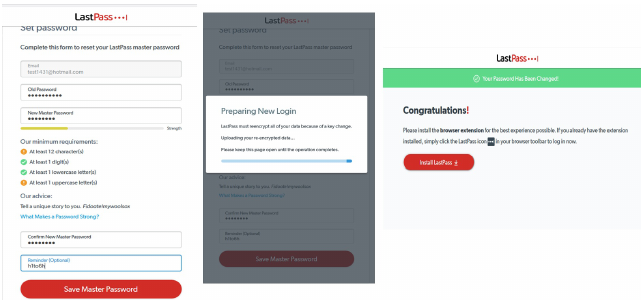
Figure A13. LastPass allows users to create a weak master password that does not match its policy.